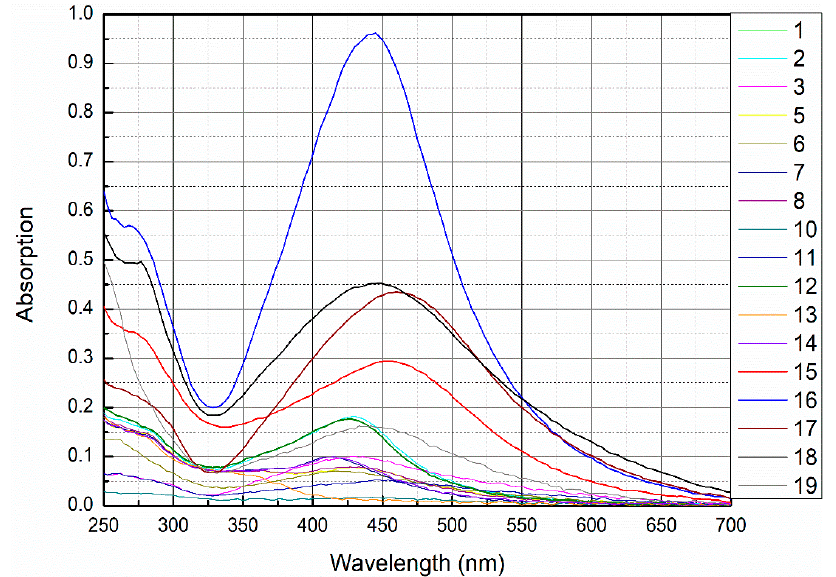
Figure 2. UV-VIS spectra of AgNPs synthesized with varying amounts of AgNO 3 and different amounts of plant extract (numbers refer to the sample number shown in Table 1). amounts of plant extract (numbers refer to the sample number shown in Table Measurement of Concentration through Absorption Peak in UV-VIS Spectrum